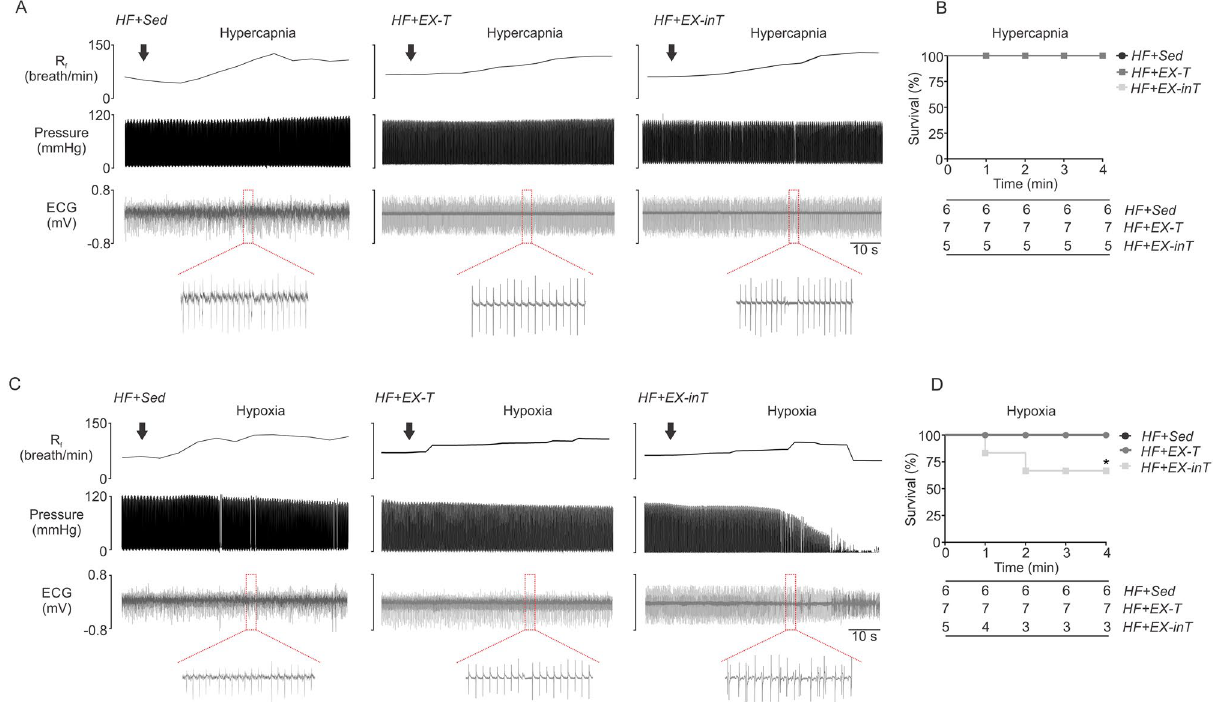
Figure 4. Moderate hypoxia but not hypercapnia increases mortality in exercise intolerant heart failure rats. ( A ) Representative recordings of respiratory frequency (R f ), intraventricular pressure, and the electrocardiogram (ECG) from one HF + Sed, one HF + EX-T, and one HF + EX-inT rat during acute hypercapnic exposure (F i CO 2 7%) (arrow, hypercapnia ON). Note that hypercapnic exposure lead to cardiac arrhythmias only in HF + EX-inT. ( B ) Kaplan–Meier survival curves showing no mortality during hypercapnia. ( C ) Representative recording of R f , intraventricular pressure, and ECG from one HF + Sed, one HF + EX-T, and one HF + EX-inT rat during acute hypoxic exposure (F i O 2 10%) (arrow, hypoxia ON). Note that hypoxic exposure lead to cardiac arrhythmias only in HF rats with exercise intolerance (HF + EX-inT); ( D ) Kaplan–Meier survival curves showing that 40% of HF + EX-inT rats died during hypoxia. *p < 0.05 vs. HF + EX-T